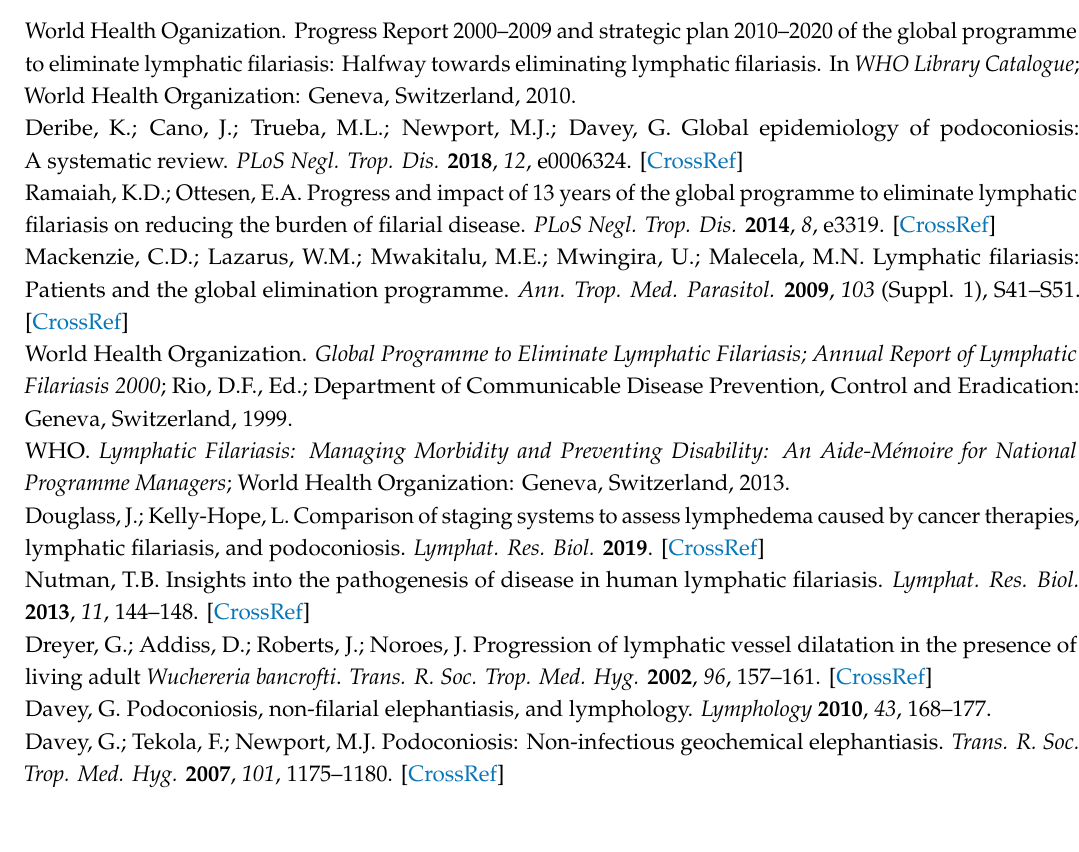
Figure S1: Standard-care brochure Bangladesh, and Figure S2: Enhanced-care brochure